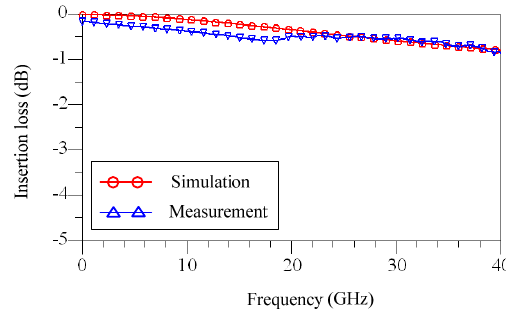
Figure 6. Simulation of insertion loss for the switch.